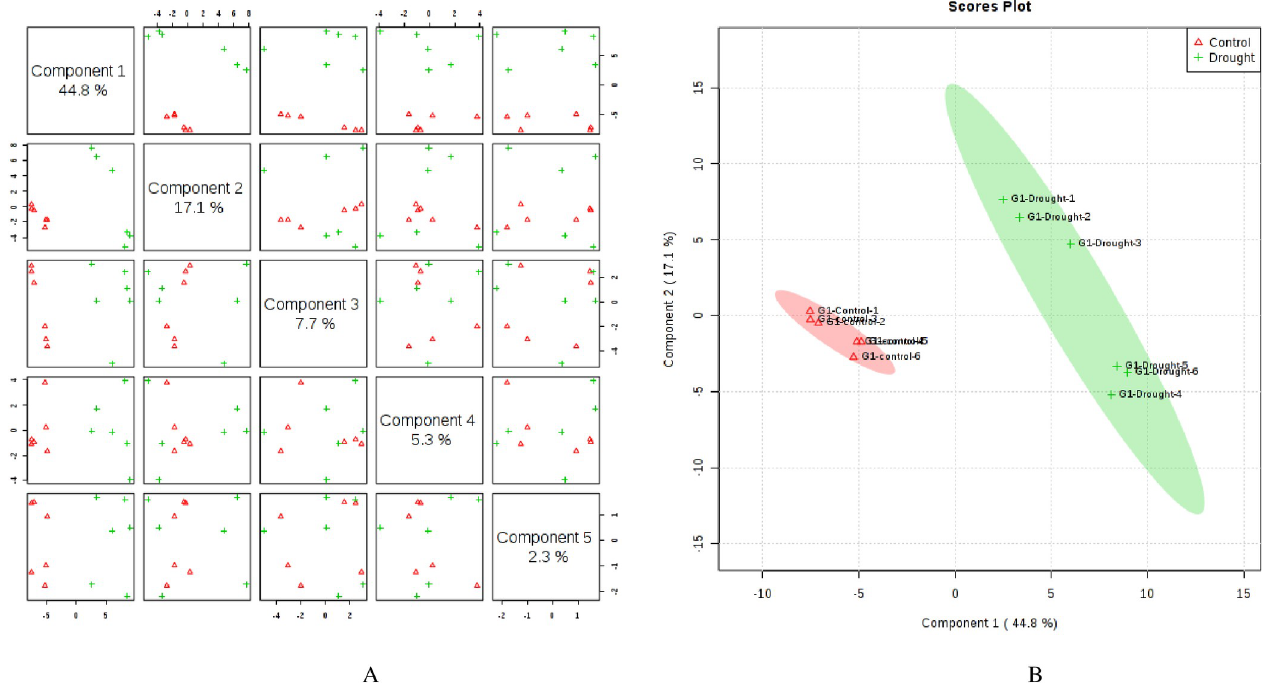
Fig 1. Partial least square discriminant analysis (PLS-DA) (A) and 2D Scores plot (B) in flag leaves of LA754 under control (irrigated) and drought conditions. Samples at control and drought treatments did not overlap with each other indicating an altered state of metabolite levels in the wheat leaves.